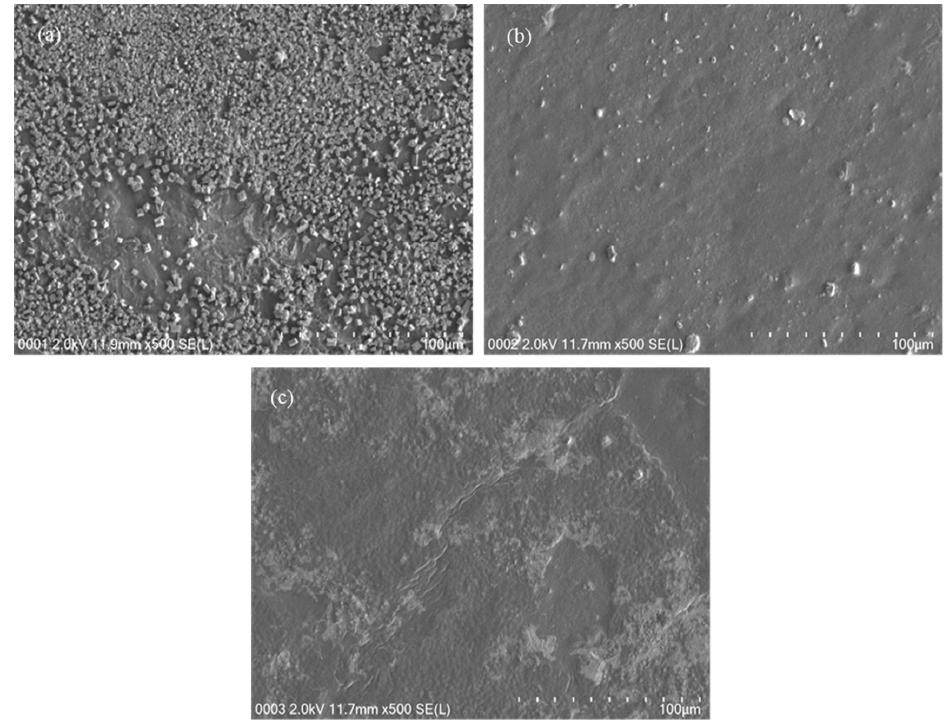
Figure 2. FESEM images for the ( a ) CSDNHP1, ( b ) CSDNHP2, and ( c ) CSDNHP3 electrolyte films.